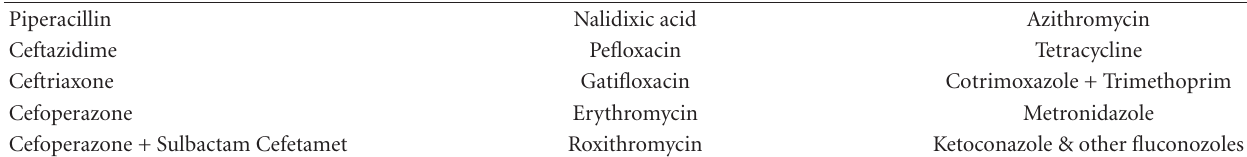
Table 2: Antibiotics which need to be used with extra caution in patients with liver failure.